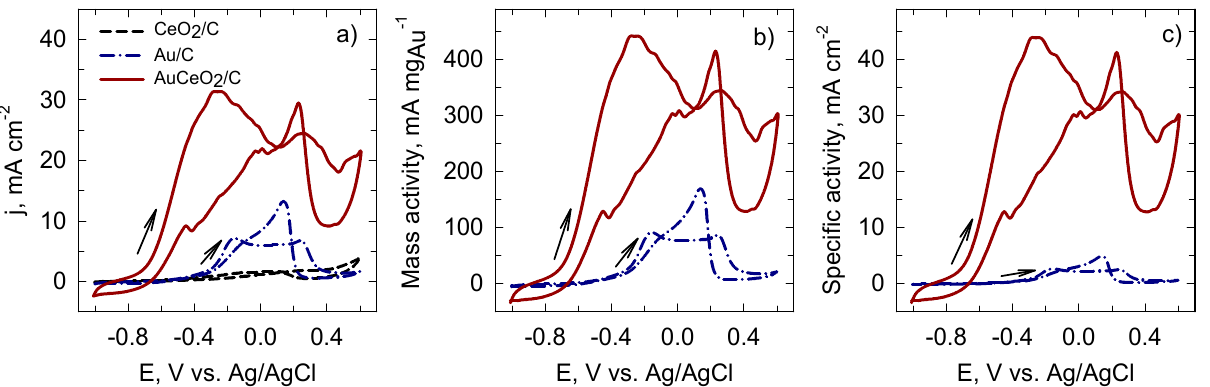
Figure 4. Comparison of current density ( a ), mass ( b ), and specific ( c ) activities of the investigated catalysts recorded in a 0.05 M BH 4 ˉ + 1 M NaOH solution at 50 mV s –1 ; 25 °C.